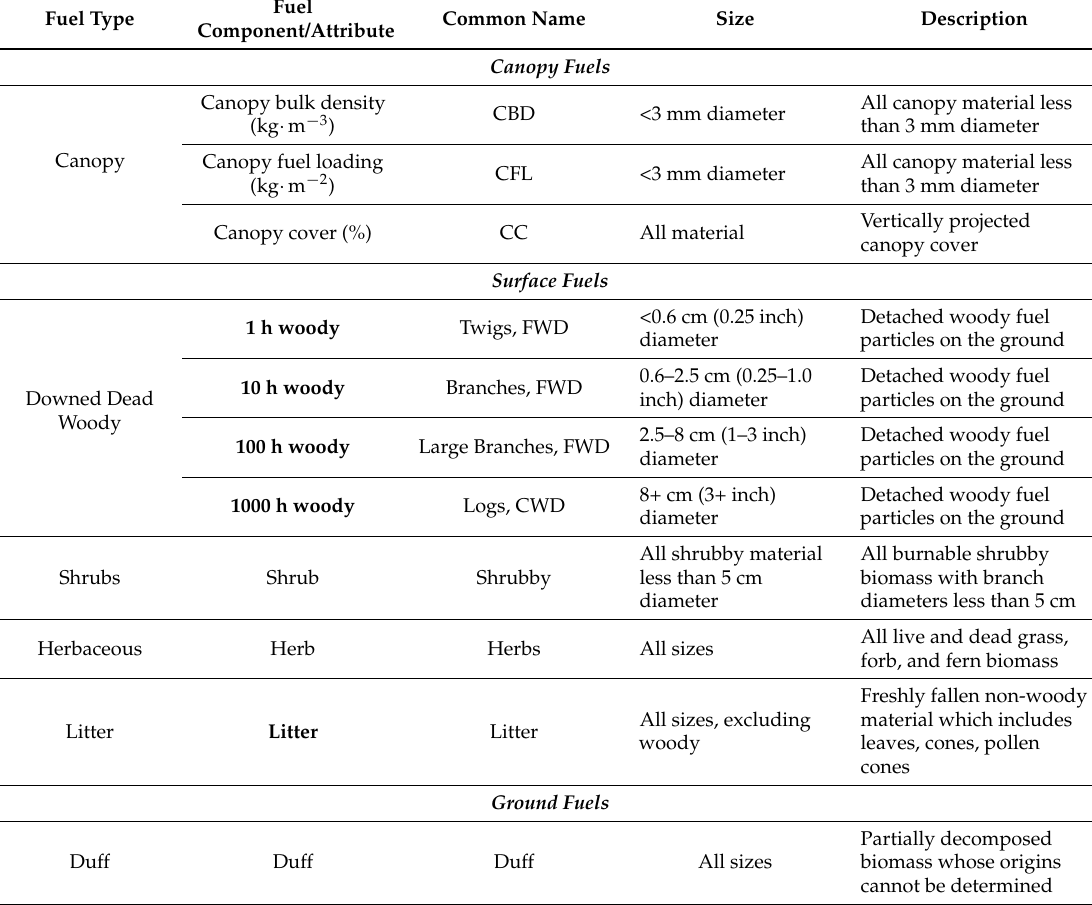
Table 1. Descriptions of the three canopy fuel characteristics, eight surface fuel components, and one ground fuel components included in this paper. FWD is fine woody debris, a term often given to wood fuel particles less than 8 cm in diameter. CWD is coarse woody debris, a term used to woody fuel particles greater than 8 cm in diameter. Those fuel components in bold indicate that they were included in the FUELDYN project, while all fuel components were included in the FUELVAR